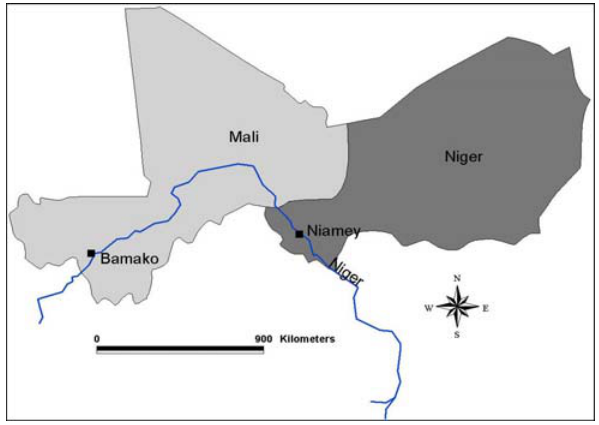
Figure 1.1 : Map of the study area